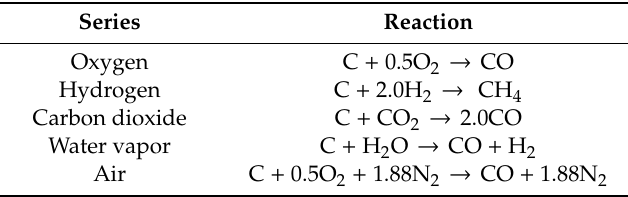
Table 2. Gasification process reactions [32].